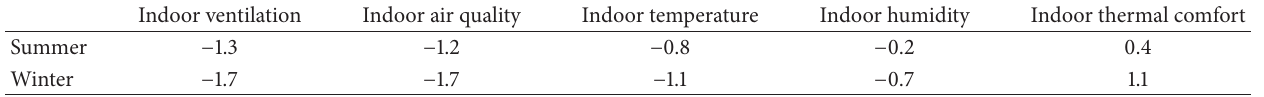
Table 2: Mean scores for environmental satisfaction.